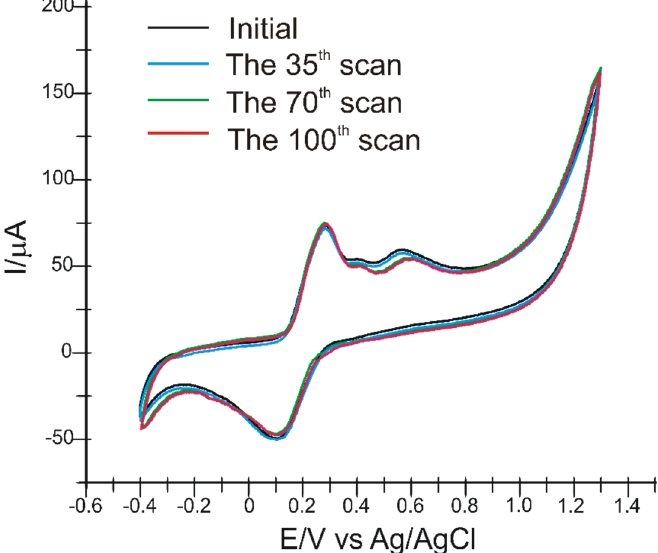
Figure 8. The repeatability of the sensor response under continuous use. Conditions: cyclic voltam- metry, in solution of 10 − 3 M CA and FA (0.1 M PBS, pH 7.0).